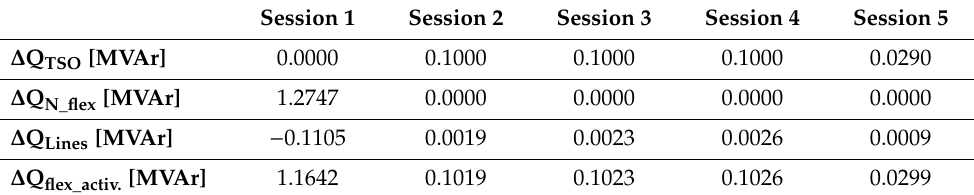
Table 4. Reactive power balance for increasing TSO capacitive needs at each market session